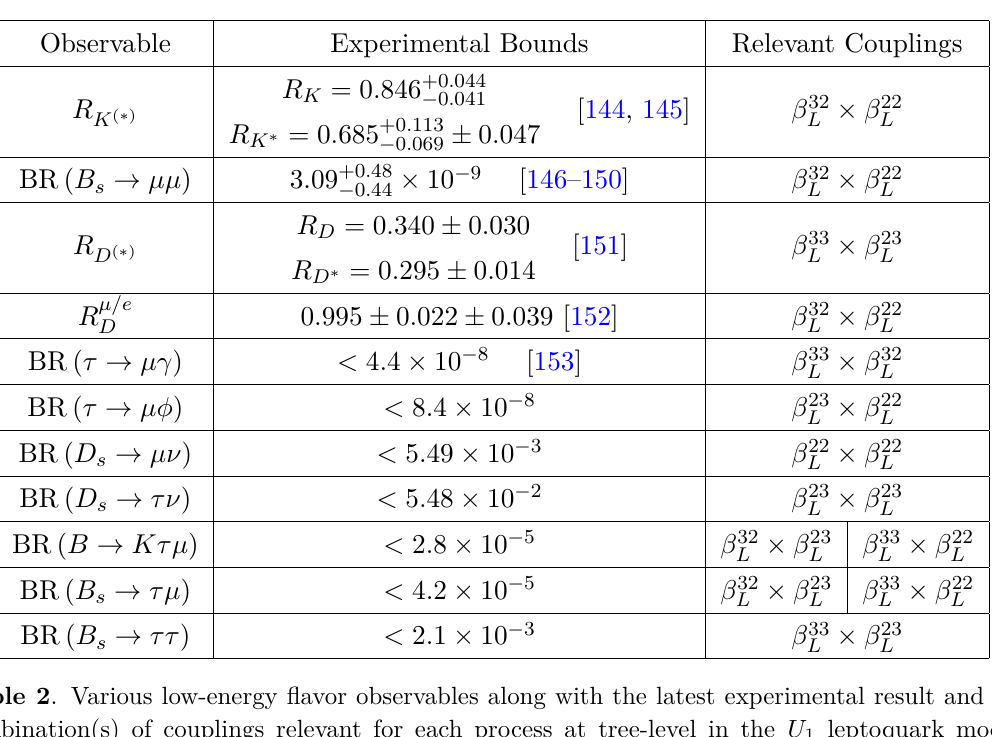
anomaly (left) and B s → µ + µ − K